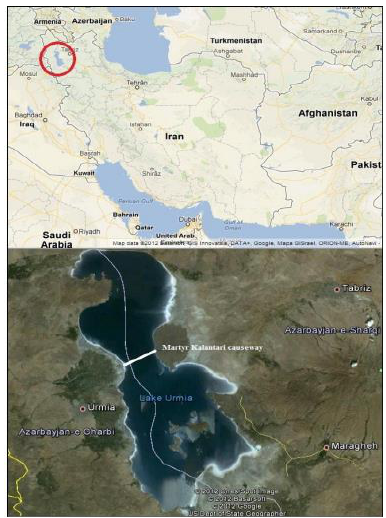
Figure 2. The map above shows the location of Urmia Lake in Iran. The other presents the Urmia Lake’s general shape. The bold line in the middle of the lake is the Martyr Kalantari causeway and the vertical line over the lake is the border between two provinces of East and West Azerbaijan (Google Earth, 2012)